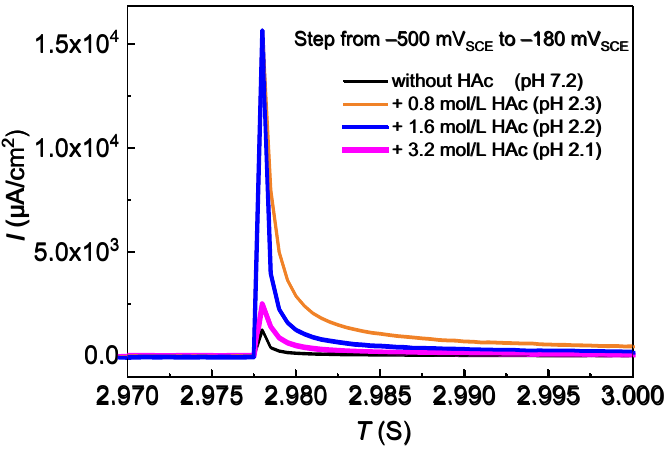
Figure 6. Current time-curves of 304 SS in 0.6 mol/L NaCl solutions with HAc during the step tests of the potential.